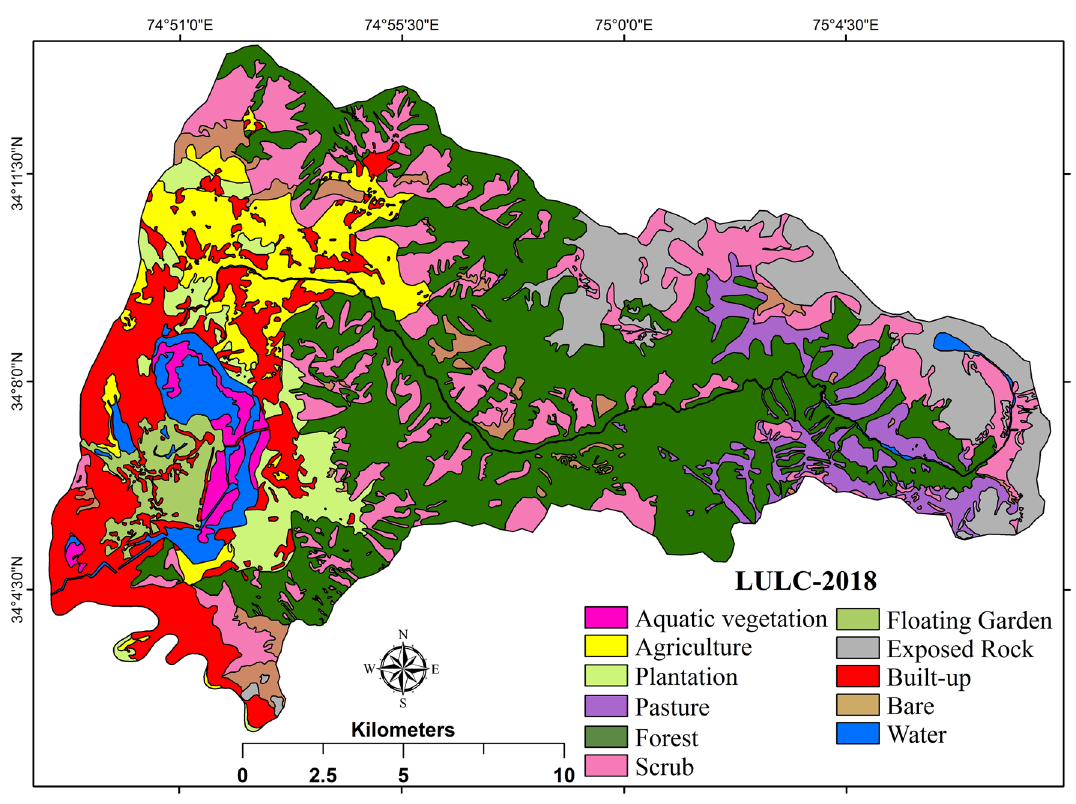
Fig. 7 LULC map of 2018